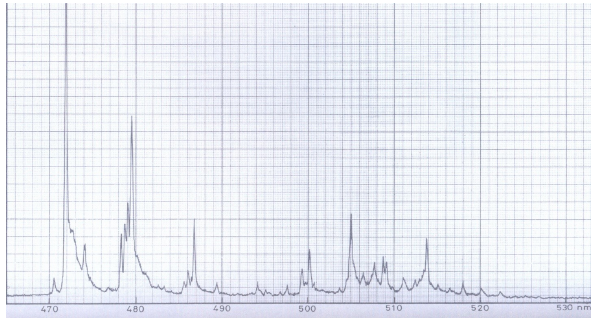
Figure 2. The spectrum of quasilinear photoluminescence of naph- thacene in n-nonane (Nakhimovsky et al.